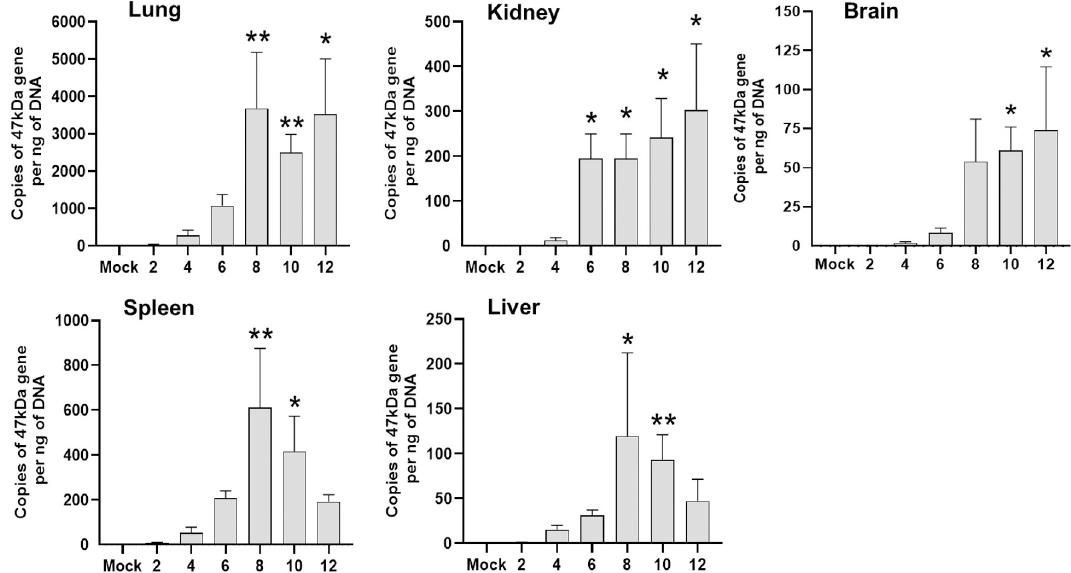
Fig 2. Organ bacterial burden in CD-1 mice following infection with O . tsutsugamushi . CD-1 mice were inoculated i.v. with O . tsutsugamushi Karp strain (4.32 × 10 4 FFU) or PBS (mock). At indicated days post-infection, organs were collected (3-4/group) for DNA extraction and bacterial burden analysis by qPCR. Data are presented as mean ± SEM. One-way ANOVA (non-parametric) was used for statistical analysis. � , p < 0.05; �� , p <